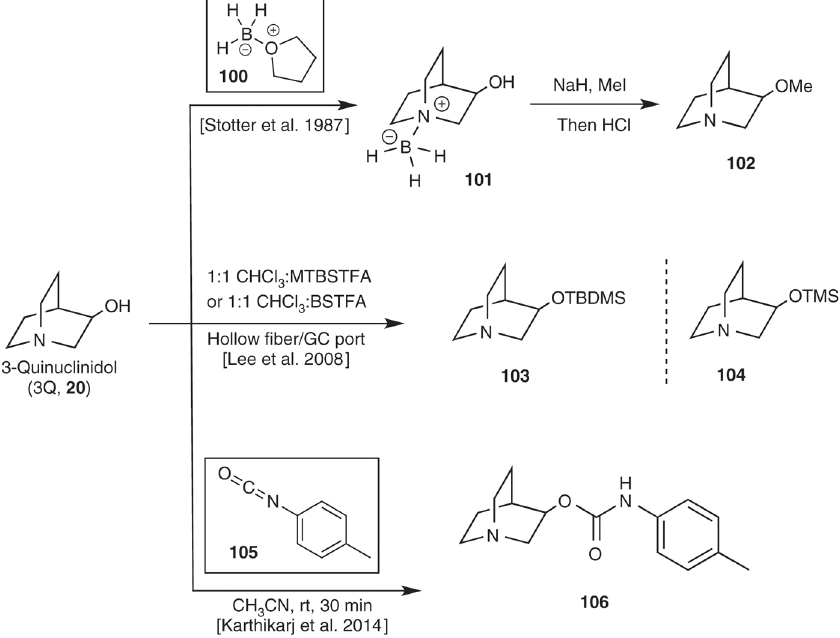
Figure 19: Derivatization strategies for